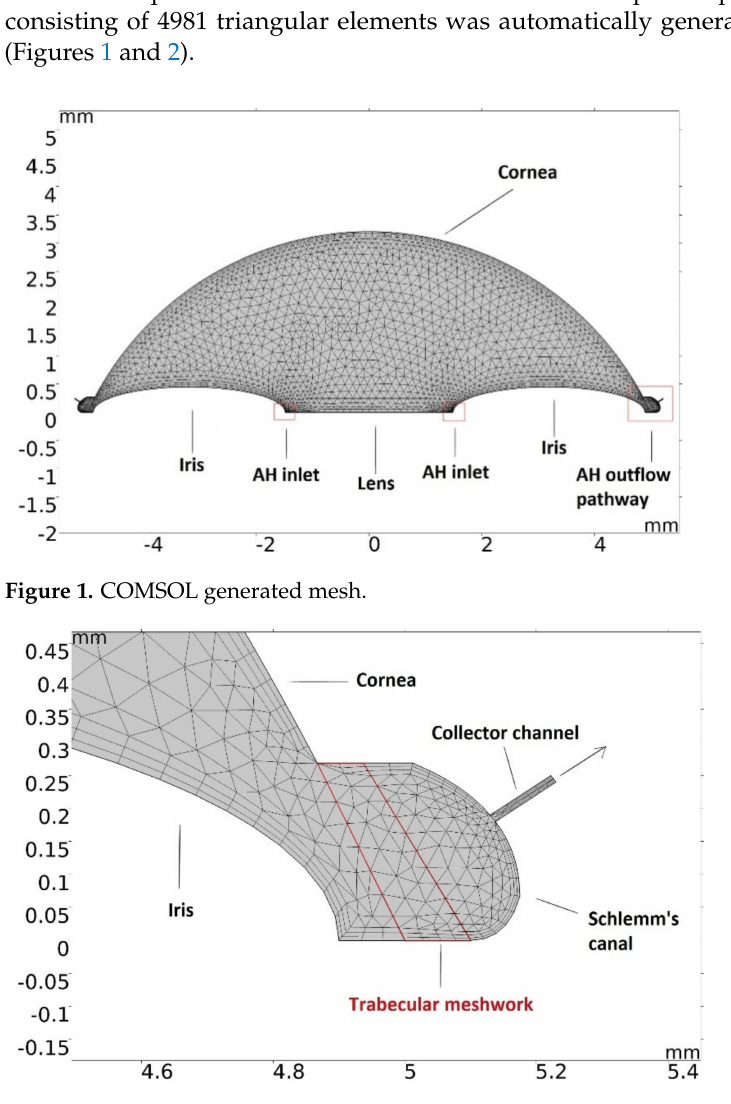
Figure 2. AH outflow pathway